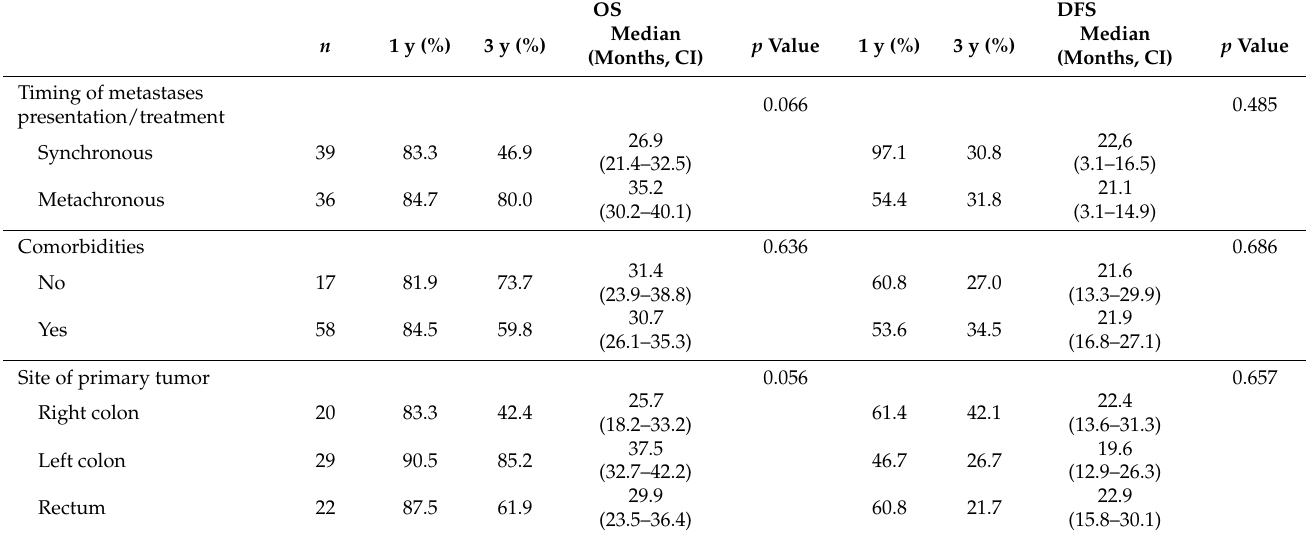
Table 3. Univariate analyses of the factors associated with overall survival and disease-free